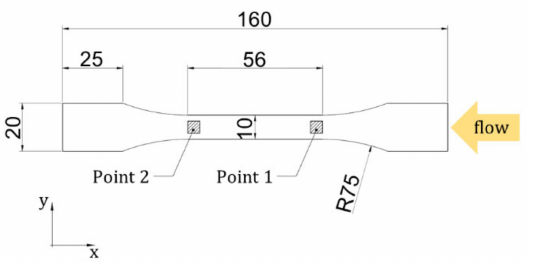
Figure 2. Design of the injection-molded tensile specimen (thickness: 4